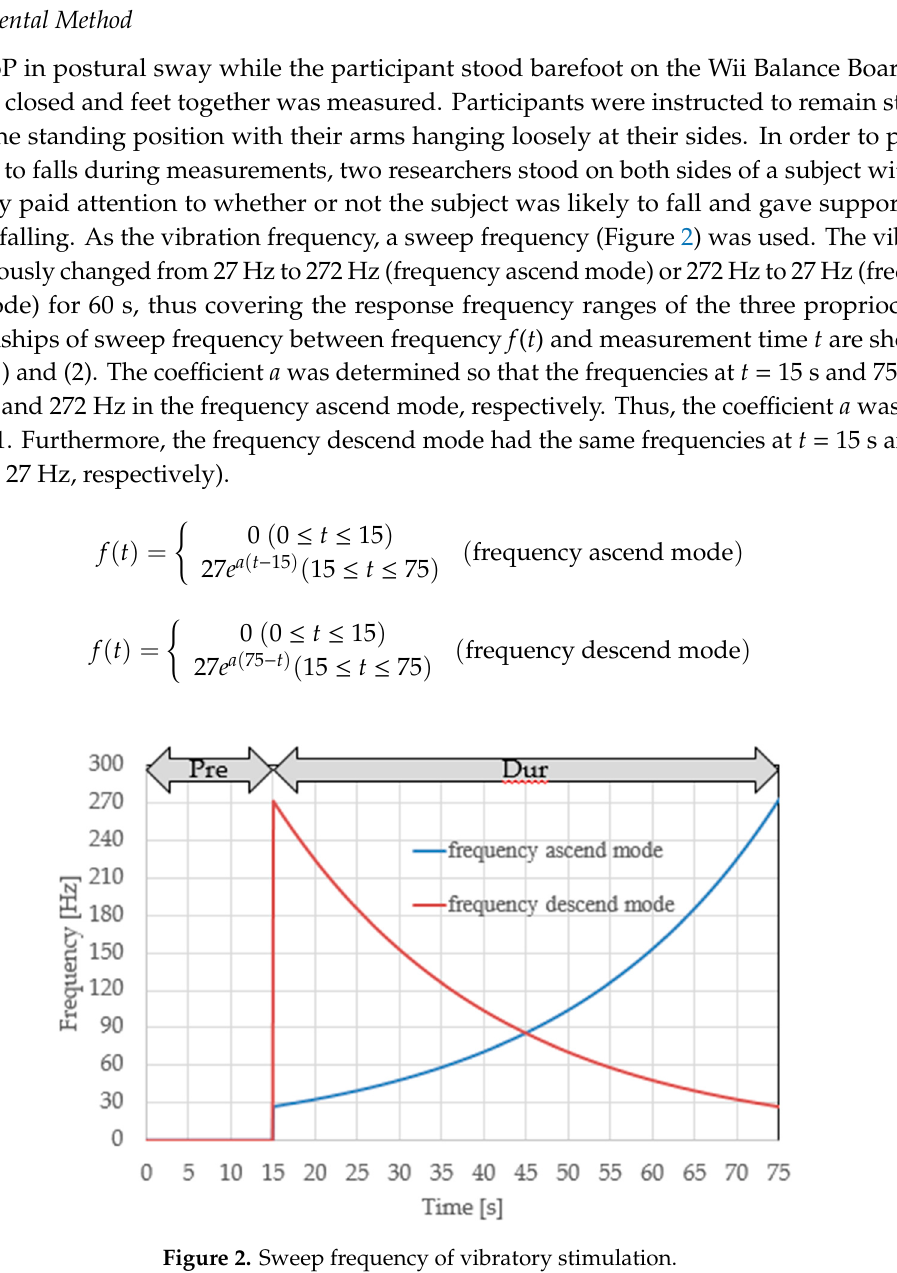
Figure 2. Sweep frequency of vibratory stimulation.